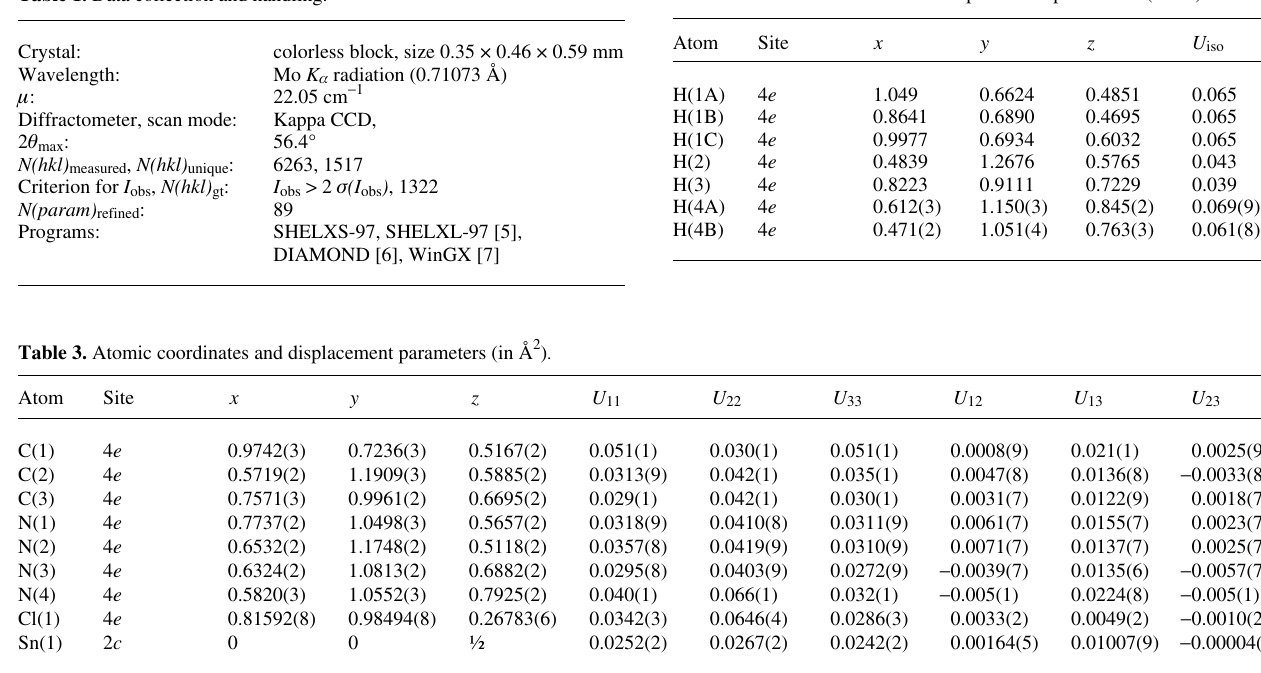
Table 2. Atomic coordinates and displacement parameters (in Å 2 ) . Table 1. Data collection and